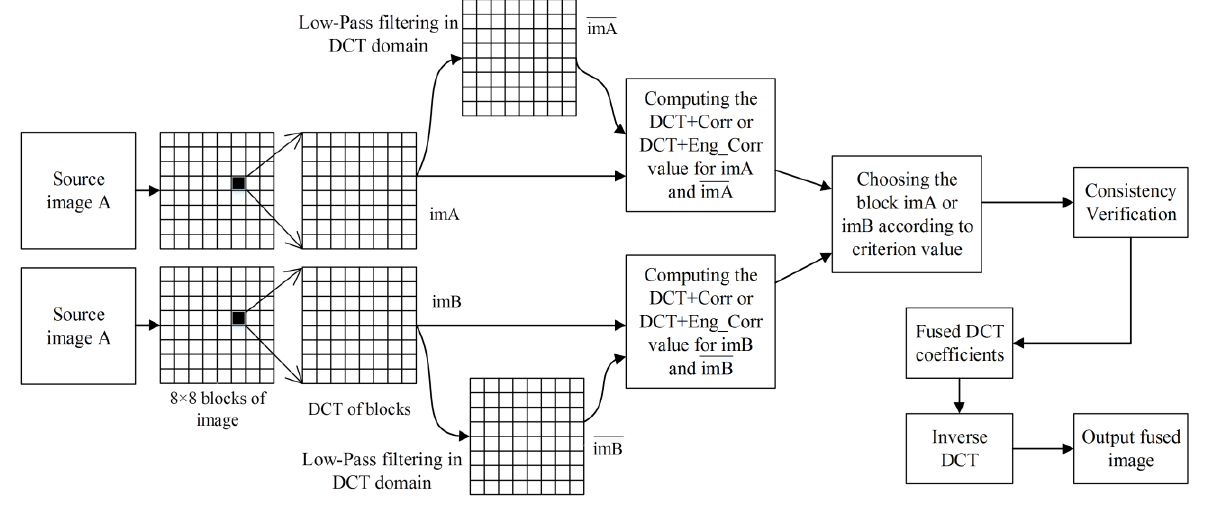
Figure 1. General structure of first approach in proposed methods.